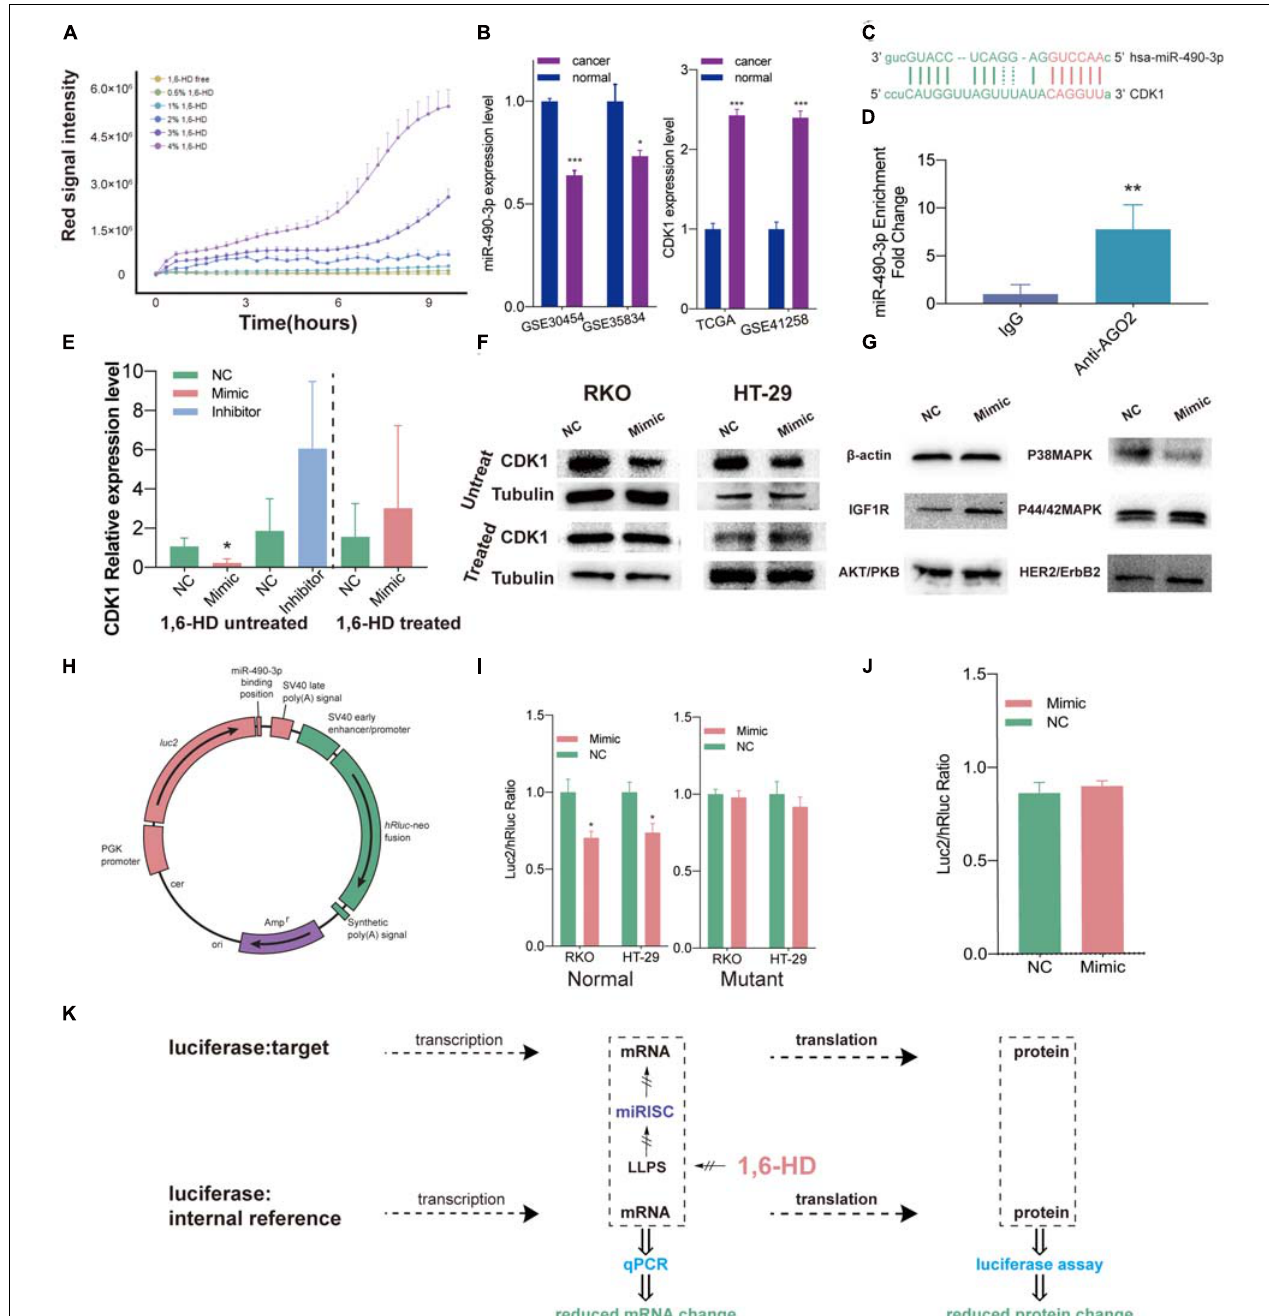
FIGURE 2 | LLPS of miRISC in colon cancer cells under nature condition. (A) The relationship between 1,6-HD concentration and cell death. Red signal intensity represents necrosis cells number as time elapse. This figure illustrated the relationship between different 1,6-HD concentration and different treat time. 1% 1,6-HD treatment could hold less cell necrosis long with time elapse. (B) Expression level of miR-490-3p and CDK1 in TCGA and GEO database. Significantly lower expression level of miR-490-3p and higher CDK1 level were observed. (C) Predicted binding site between miR-490-3p and CDK1. (D) RIP analysis exhibits the colocalization between miR-490-3p and Ago2. (E) RT-qPCR assays under 1,6-HD treated and untreated condition. When not treated with 1,6-HD, lower CDK1 expression was observed in mimic group and higher expression was observed in inhibitor group. In treated group, this trend is disappeared. (F) Western blot shows less expression of CDK1 in mimic group when not treated with 1,6-HD and equally expression level in mimic group when treated with 1,6-HD. (G) Western blot shows less expression of P38MAPK in mimic group. (H) Profile of normal luciferase plasmid. (I) Luciferase assays of normal (left panel), mutant (right panel). Significantly lower CDK1 expression could be observed in mimic of normal group, which couldn’t be seen in mutant group. (J) Equal signal of luciferase assay could be observed when treated with 1,6-HD. (K) Ideograph for luciferase assays. * P < 0.05, ** P < 0.01, *** P < 0.001.